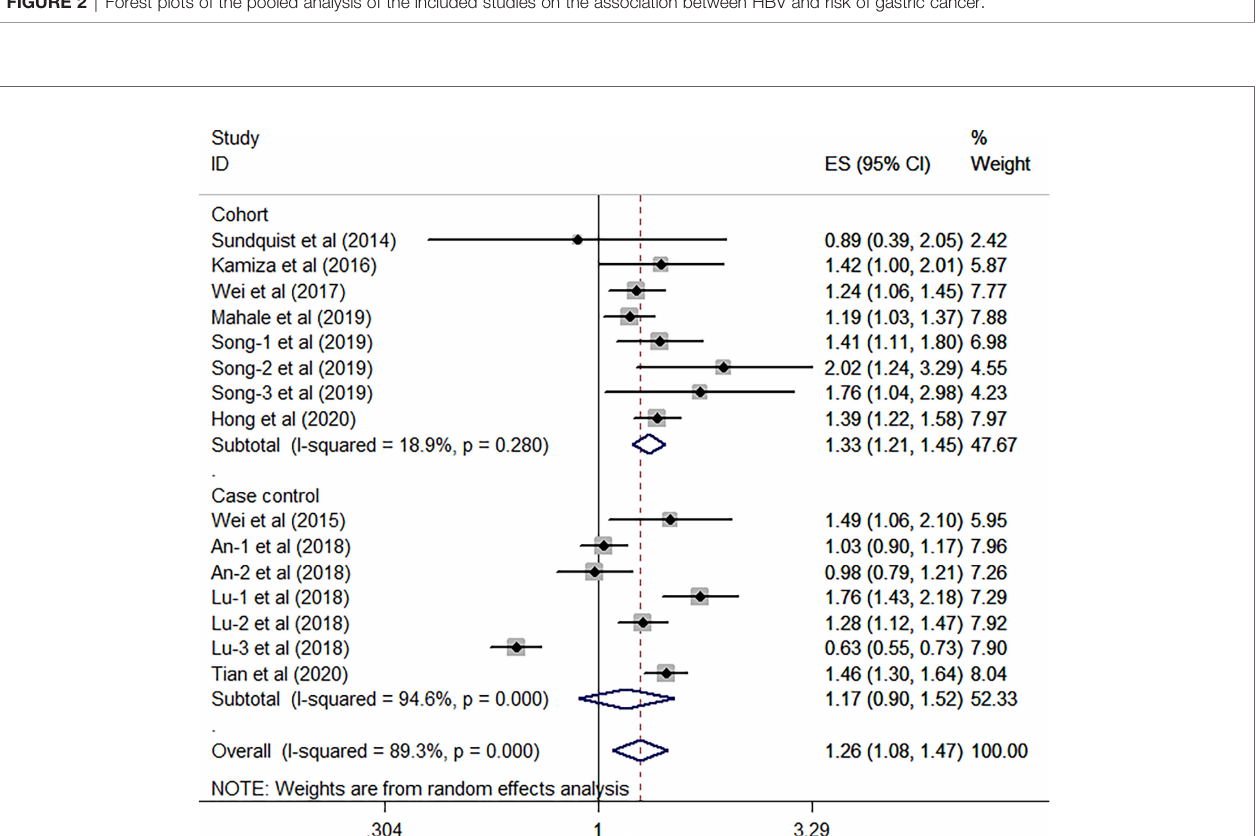
Frontiers in Oncology |